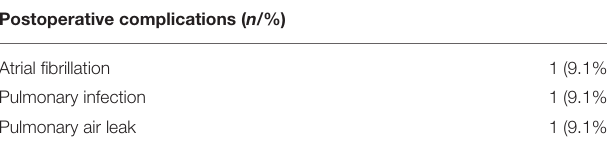
TABLE 5 | Postoperative complications of